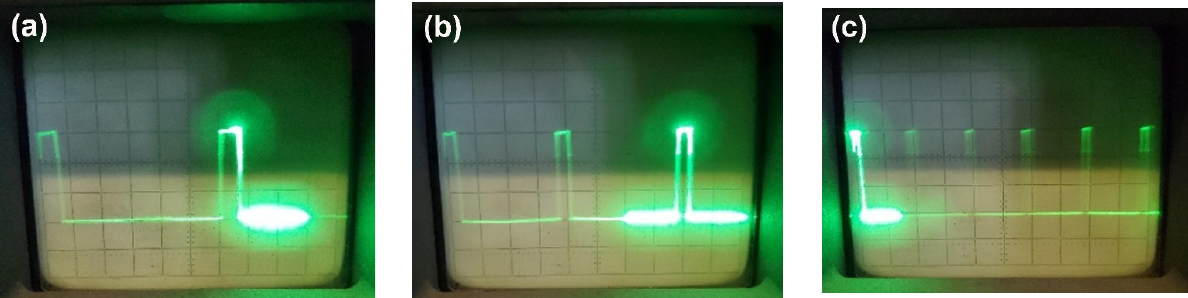
Figure 7. The oscillograms of the atomizing airflow with the pulsation’s frequency of ( а ) 20 Hz, ( b ) 50 Hz, ( c ) 100 Hz.